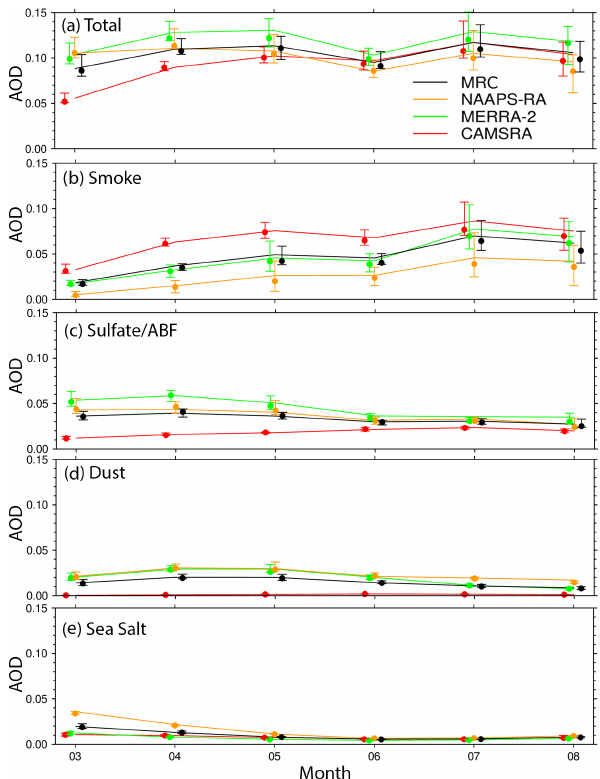
Figure 6. Climatological (2003–2019) seasonal cycle of Arctic (60–90 ◦ N) average total and speciated AODs at 550nm from the three aerosol reanalyses and the MRC. The top and bottom whiskers and the symbols represent, respectively, the 25% and 75% per- centiles and the medians of monthly binned AOD distributions.